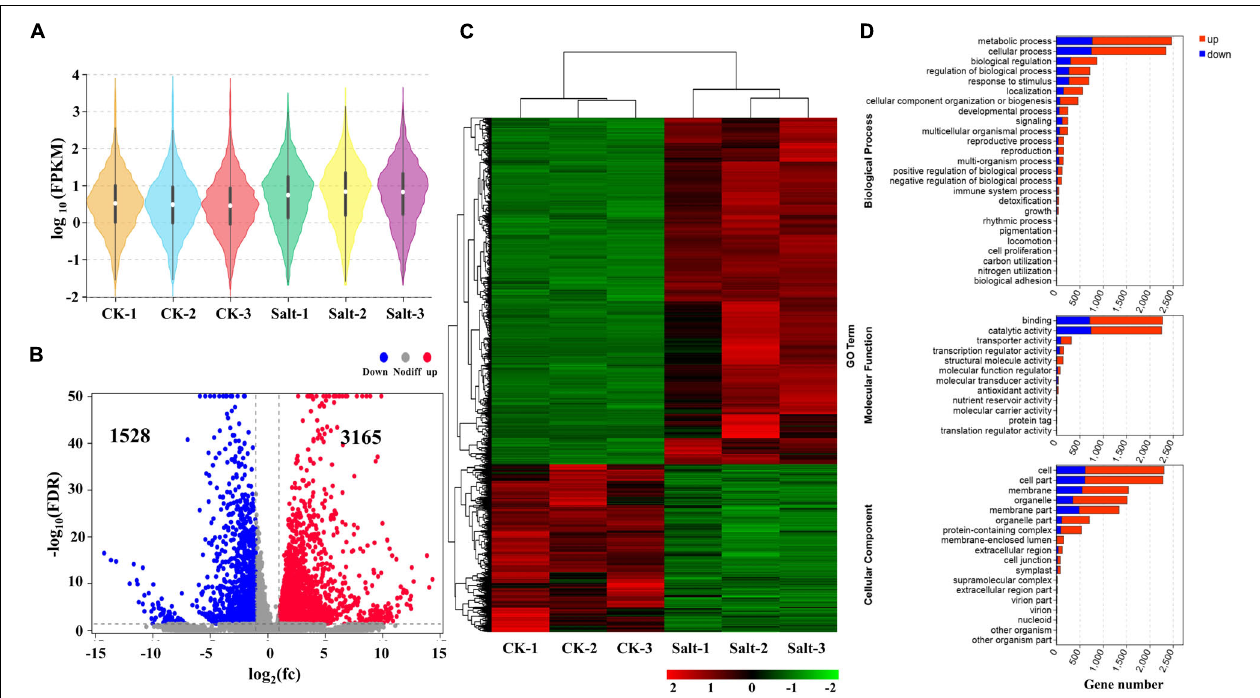
FIGURE 1 | Identification and analysis of mRNAs and DEmRNAs in Medicago truncatula leaf under salt stress. (A) FPKM distribution of mRNAs in six samples. (B) DEmRNAs statistics after salt treatment. (C) Heat map of all DEmRNAs. (D) GO enrichment of all DEmRNAs.